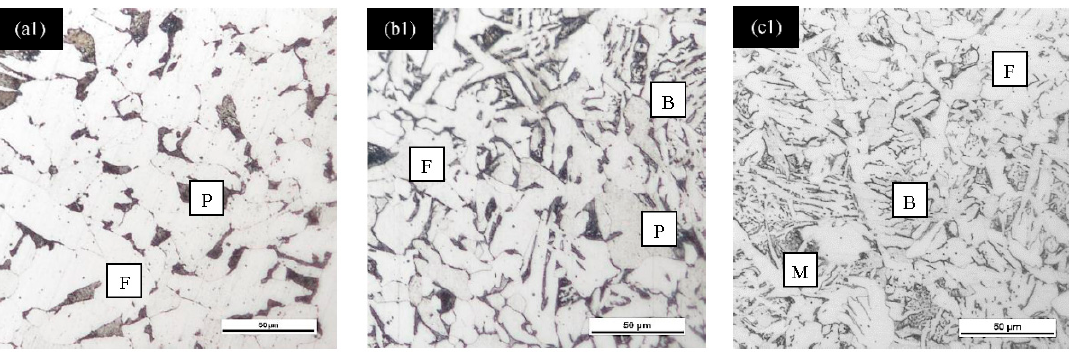
Figure 3. Optical imaging of different quenching rate at ( a1 ) 1 ° C/s, ( b1 ) 6 ° C/s and ( c1 ) 50 ° C/s